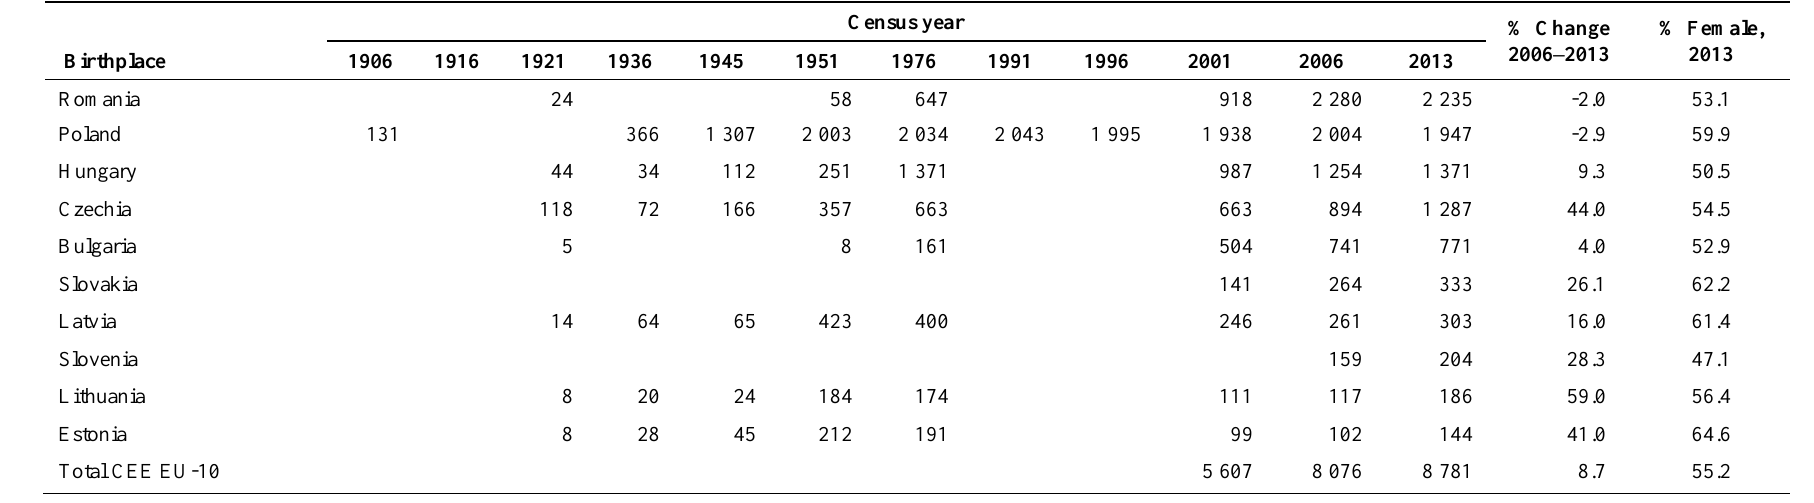
Table 7. Birthplace for the census usually resident population count, CEE EU-10 countries, selected census years,